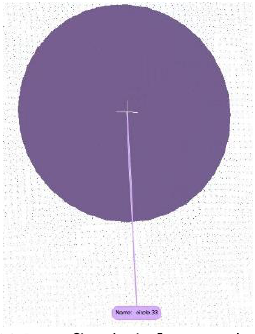
Figure 10 Best fitted circle to marker points